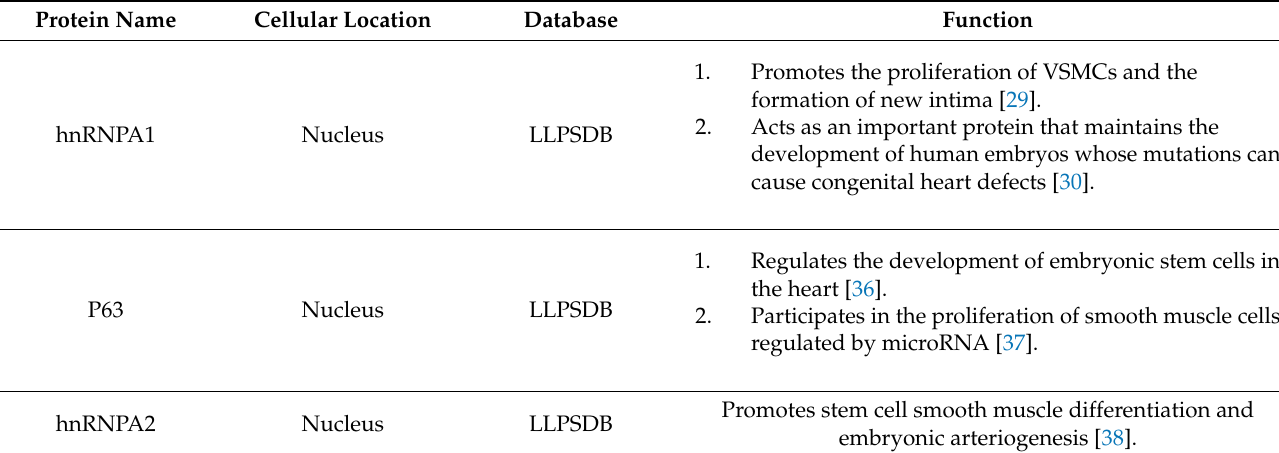
Table 1. Proteins that are phase-separated in the cardiovascular